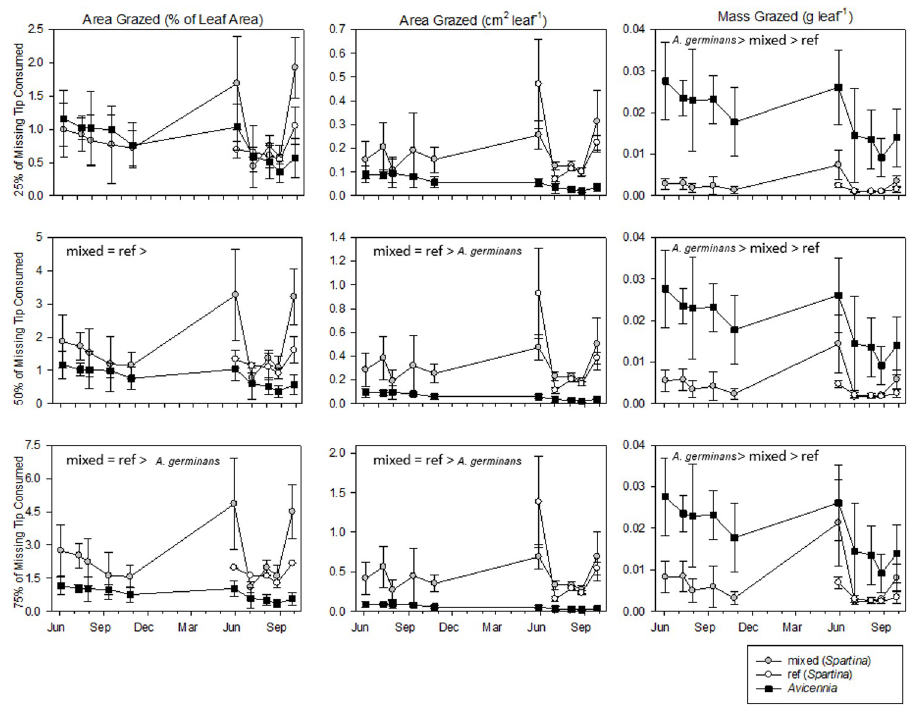
Fig 3. Leaf herbivory of A . germinans and S . alterniflora -mix (6 separate analyses) over 2012–2013. Grazing on leaf tissue was compared on the bases of percentage of total leaf area (left column plots), absolute leaf area (center column), and absolute leaf mass (right column). Note y-axes’ scales vary in left and center columns. Values between top, middle, and bottom rows vary only for S . alterniflora , with different assumptions of missing tip consumption (top: 25%, middle: 50%, bottom: